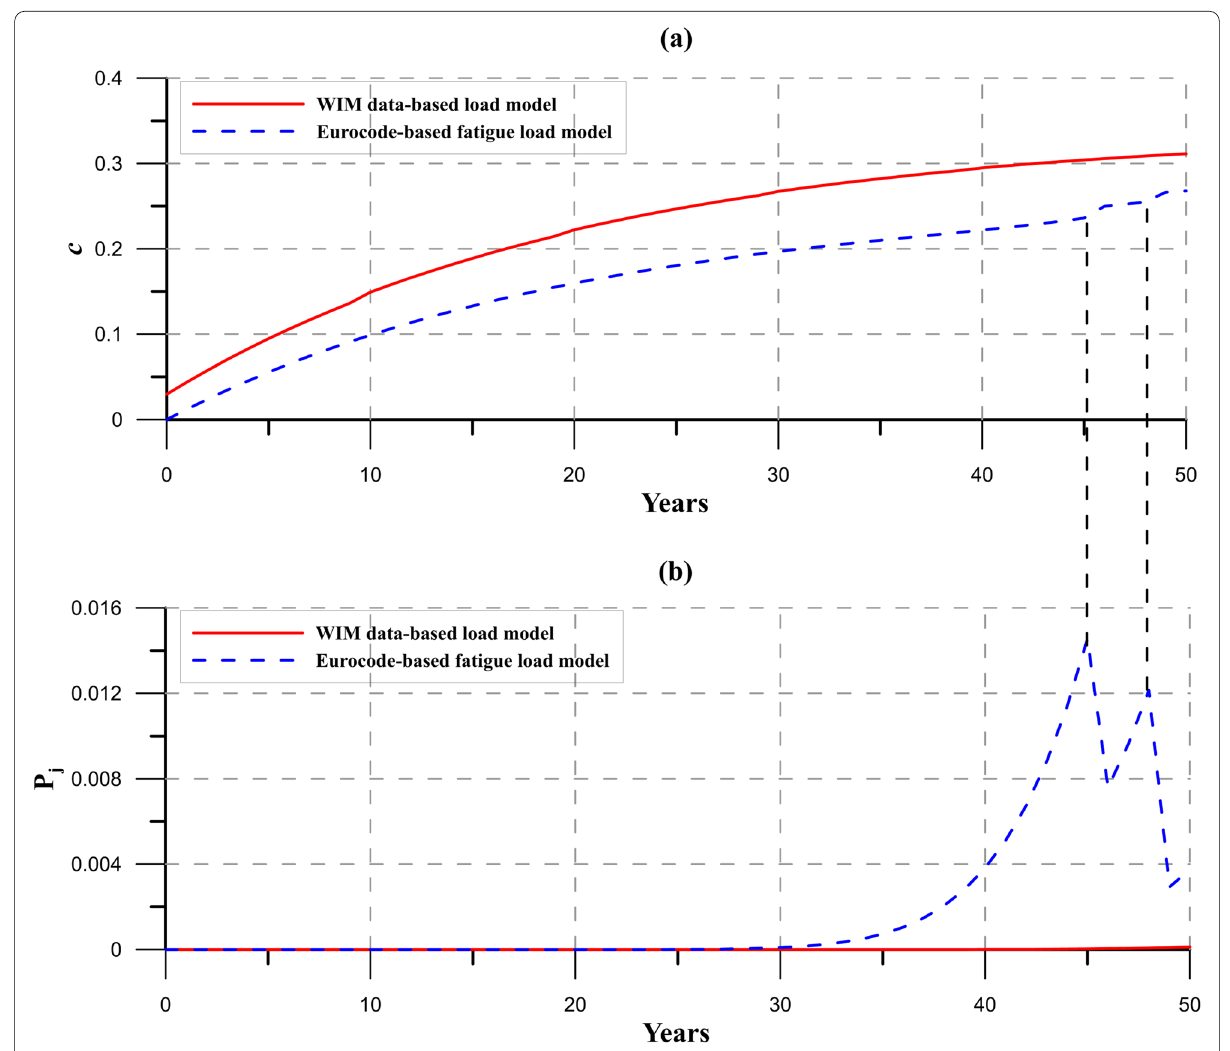
Fig. 7 Expected normalized costs over the lifetime of the bridge ( a ) and the related probability ( b